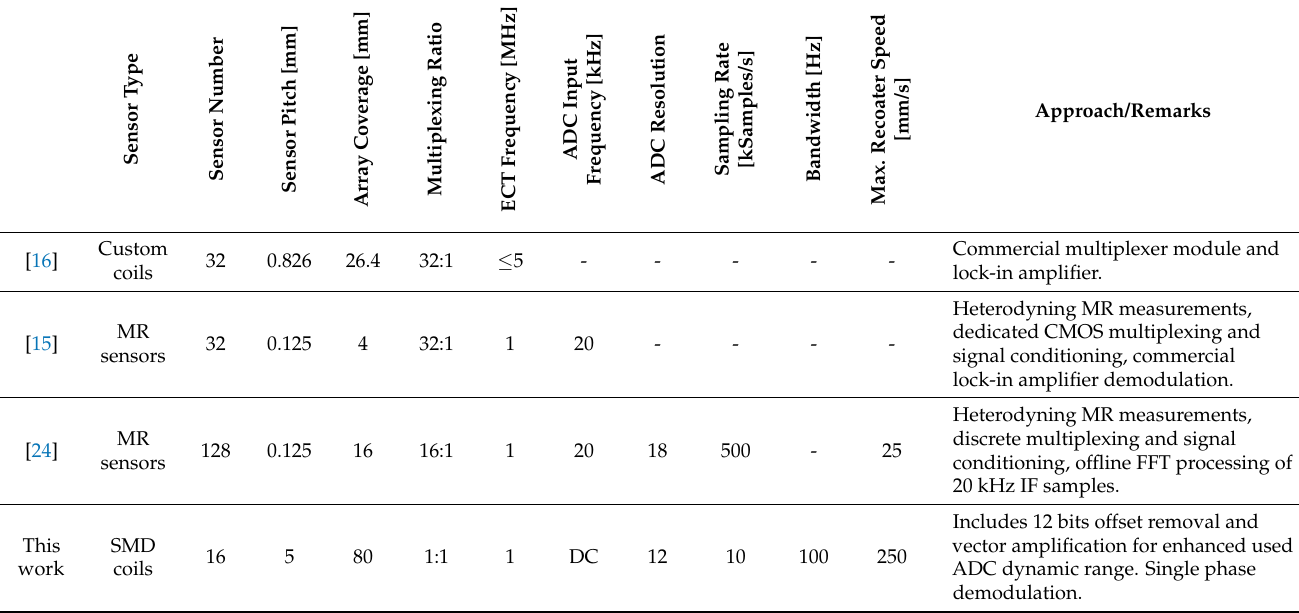
Table 3. Comparison with other